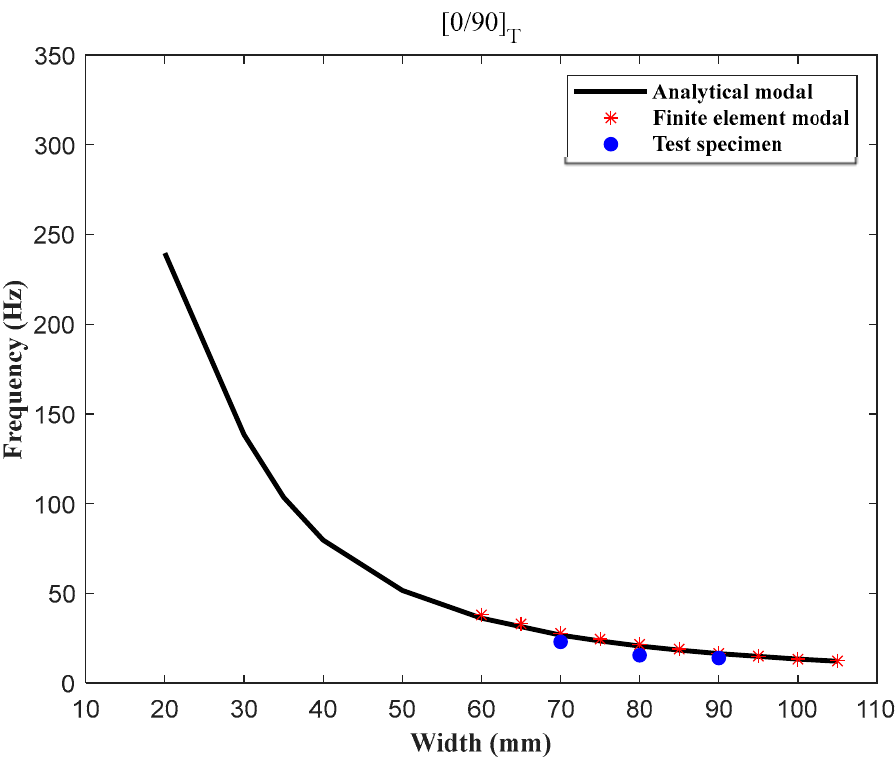
Figure 8. First-order natural frequencies of laminated plates of different sizes. Table 3. First-order natural frequencies of laminated plates of different sizes.